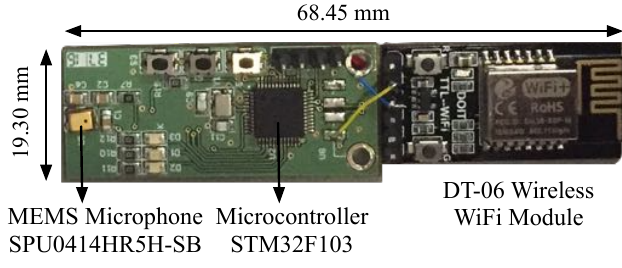
Figure 3. Ultrasonic receiver module.